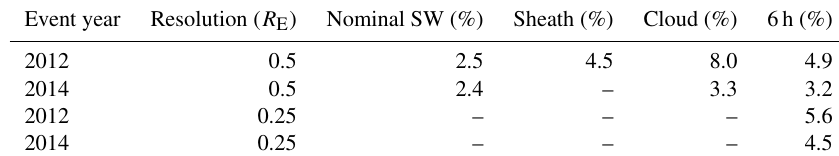
Table 2. Average relative difference magnitudes in the magnetopause nose position for a given simulation phase.